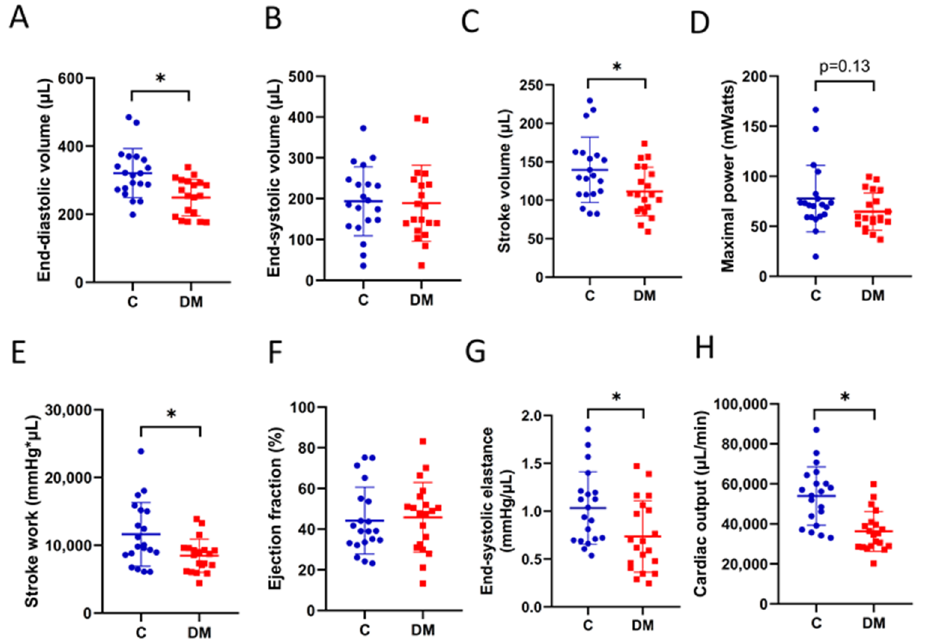
Figure 3. STZ-induced HFpEF. Cardiac hemodynamics were examined using cardiac P-V catheterization. ( A ) End-diastolic volume. ( B ) End-systolic volume. ( C ) Stroke volume. ( D ) Maximal power. ( E ) Stroke work. ( F ) Ejection fraction. ( G ) End-systolic elastance. ( H ) Cardiac output. Data are expressed as mean ± SEM ( n = 20). p -values were determined by Student’s t -test. * p < 0.05 DM vs. C.